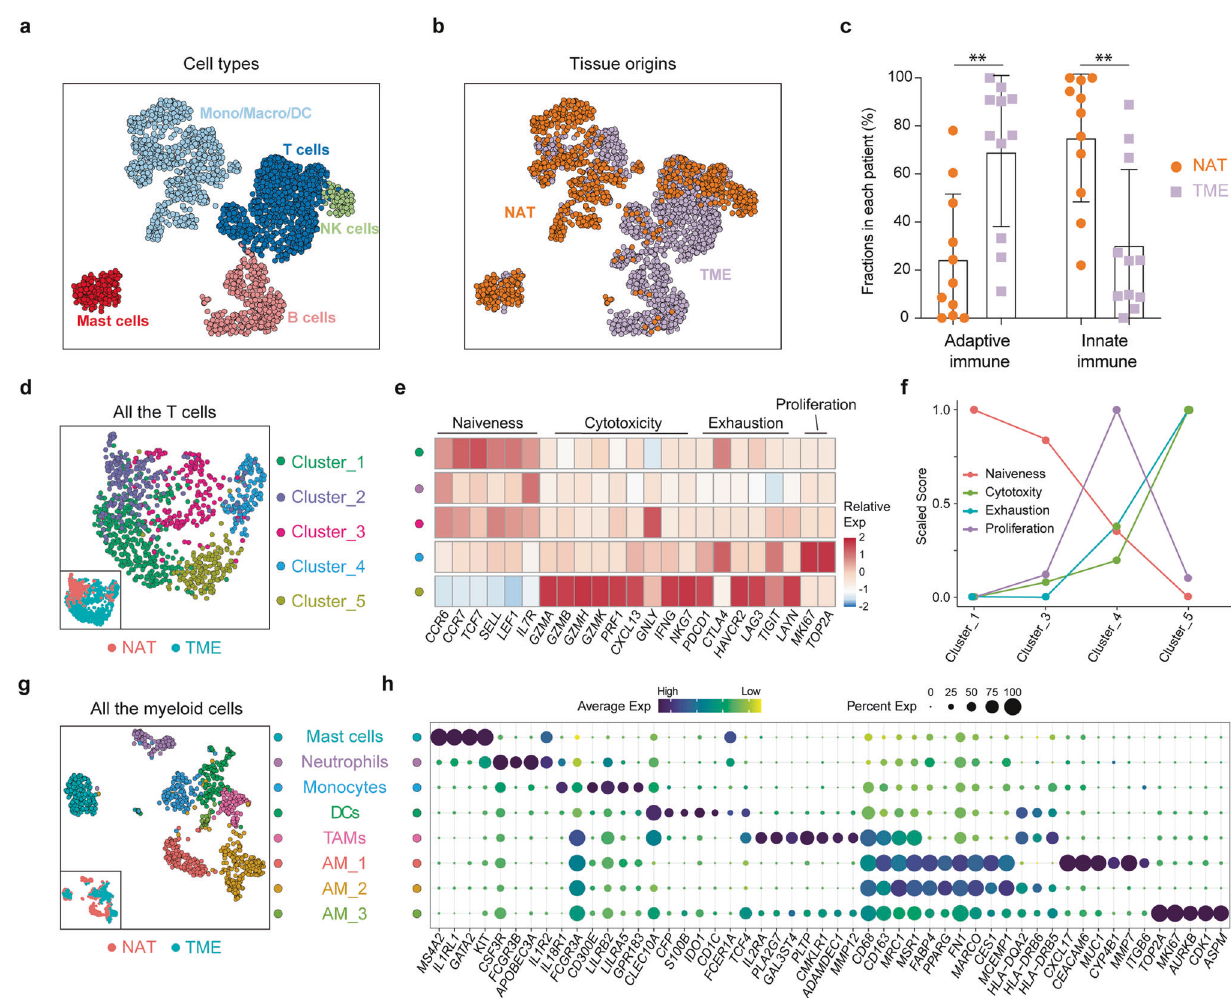
Fig. 2 The immune landscape of SCLC. a , b UMAP plot of 2,474 immune cells colored coded by cell type (T cells, NK cells, mast cells, and mono/macro/DC cells) ( a ) and tissue origin (NAT and TME) ( b ). c The fractions of T cells and B/plasma cells were higher and the in fi ltration of myeloid cells was lower in primary SCLC tumors than in NATs. Statistical analyses were performed using two-way ANOVA followed by Bonferroni ’ s multiple comparisons test. ** p < 0.01. d UMAP plot of all T cells from NATs and the TME. e Heatmap of the z-score-normalized mean expression value of T cell state-associated genes in each subcluster. The T cell subclusters were colored in accordance with those in ( d) . f The naïveness, cytotoxicity, exhaustion and proliferation scores in T cell subclusters from the TME. Every score was scaled to a range of 0 to 1. g UMAP plot of all myeloid cells from NATs and the TME. h Dot plot of selected myeloid cell-associated genes in each cell lineage. Dot size and color indicate the fraction of expressing cells and normalized expression levels,